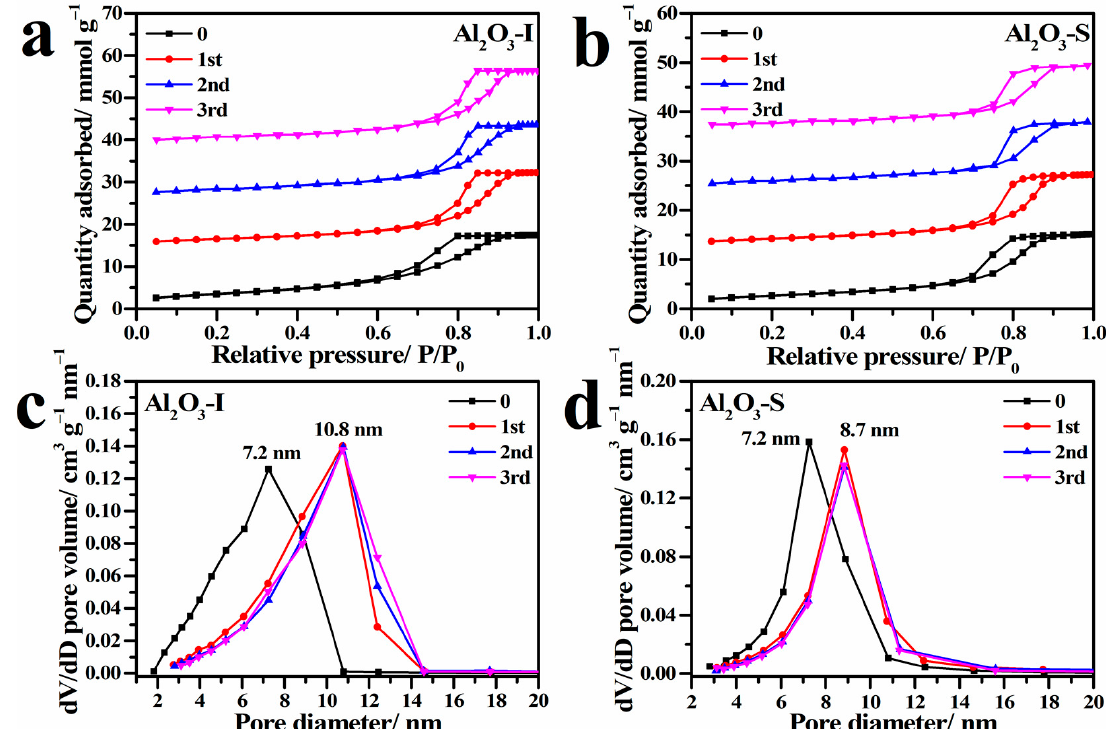
Figure 6. Adsorption–desorption isotherms and pore size distribution curves of Al 2 O 3 -I ( a , c ) and Al 2 O 3 -S ( b , d ) after hydrothermal treatment under water vapor at 600 °C for 48 h (one cycle). Here, the 0, 1st, 2nd, and 3rd samples correspond to the samples that were calcined at 600 °C for 4 h after the 0 to 3rd hydrothermal treatment cycles, respectively.